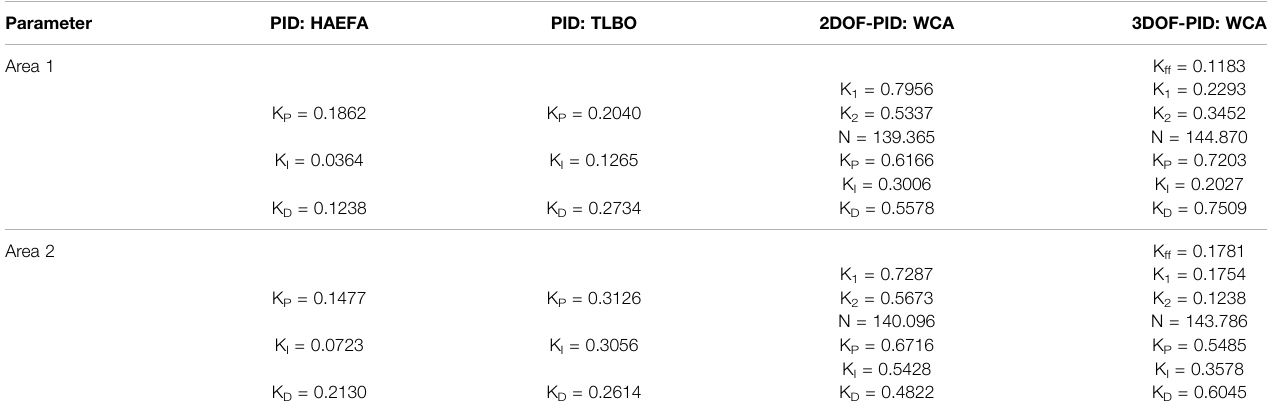
TABLE 3 | Controller optimal gains employed for the DAHT system.